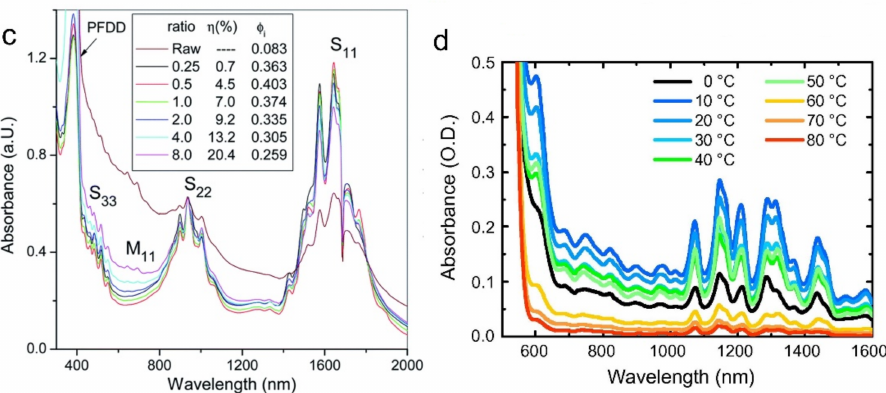
Figure 10. ( a ) The sorted-SWNT concentration changes with PFT molecular weight. The dispersion e ff ect is the best when the molecular weight is between 10–35 kg / mol. Reproduced from Imin, P. et al., 2011; ( b ) the kinematic viscosity and selectivity vary with the polymer molecular weights and solvents. Higher molecular weights and o-xylene will bring higher viscosity and selectivity change.